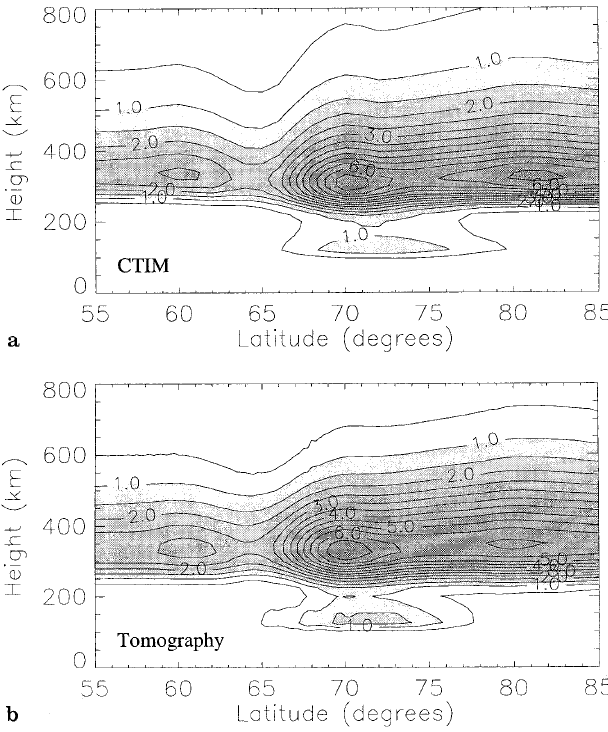
Fig. 2a, b. Contour plots of a modelled and b reconstructed electron density distributions for the altitude/latitude slice below the simulated satellite track at 15 (cid:176) E longitude. Contour values are in units of 10 10 m ) 3 . The positions of the mid-latitude trough, the auroral region and the polar cap tongue of ionisation can